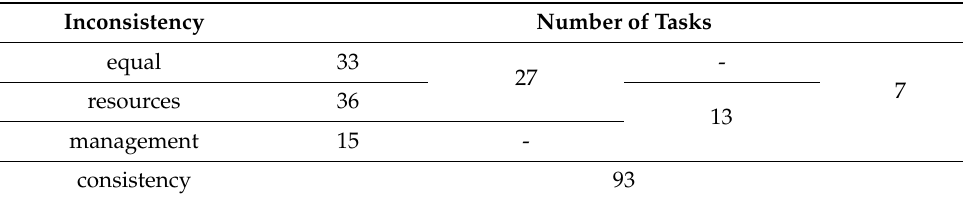
Table 4. Consistency of task conformity evaluations.